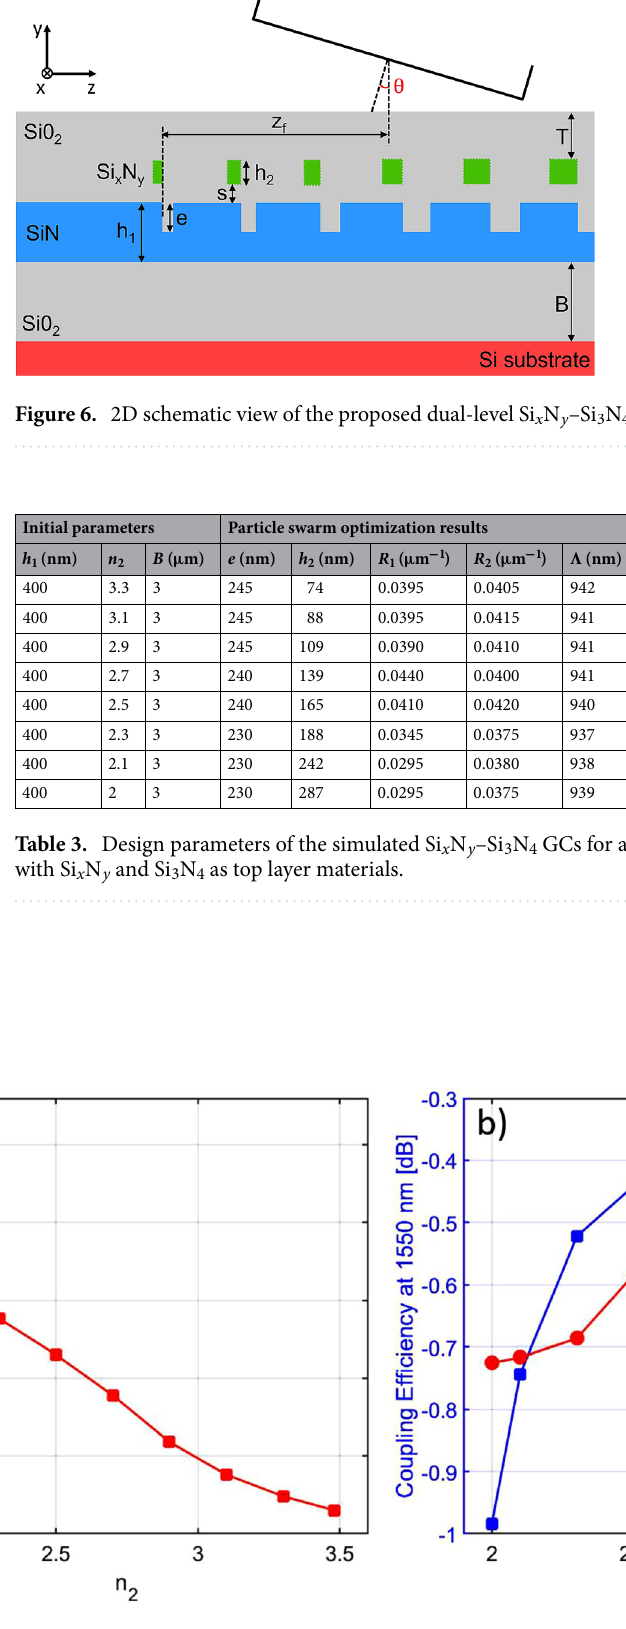
Figure 7. ( a ) Thickness h 2 which maximizes the CE as a function of the top level refractive index n 2 ; ( b ) peak CE at 1550 nm and 1 dB BW as a function of n 2 for dual-level Si x N y –Si 3 N 4 GC for a 400 nm thick Si 3 N 4